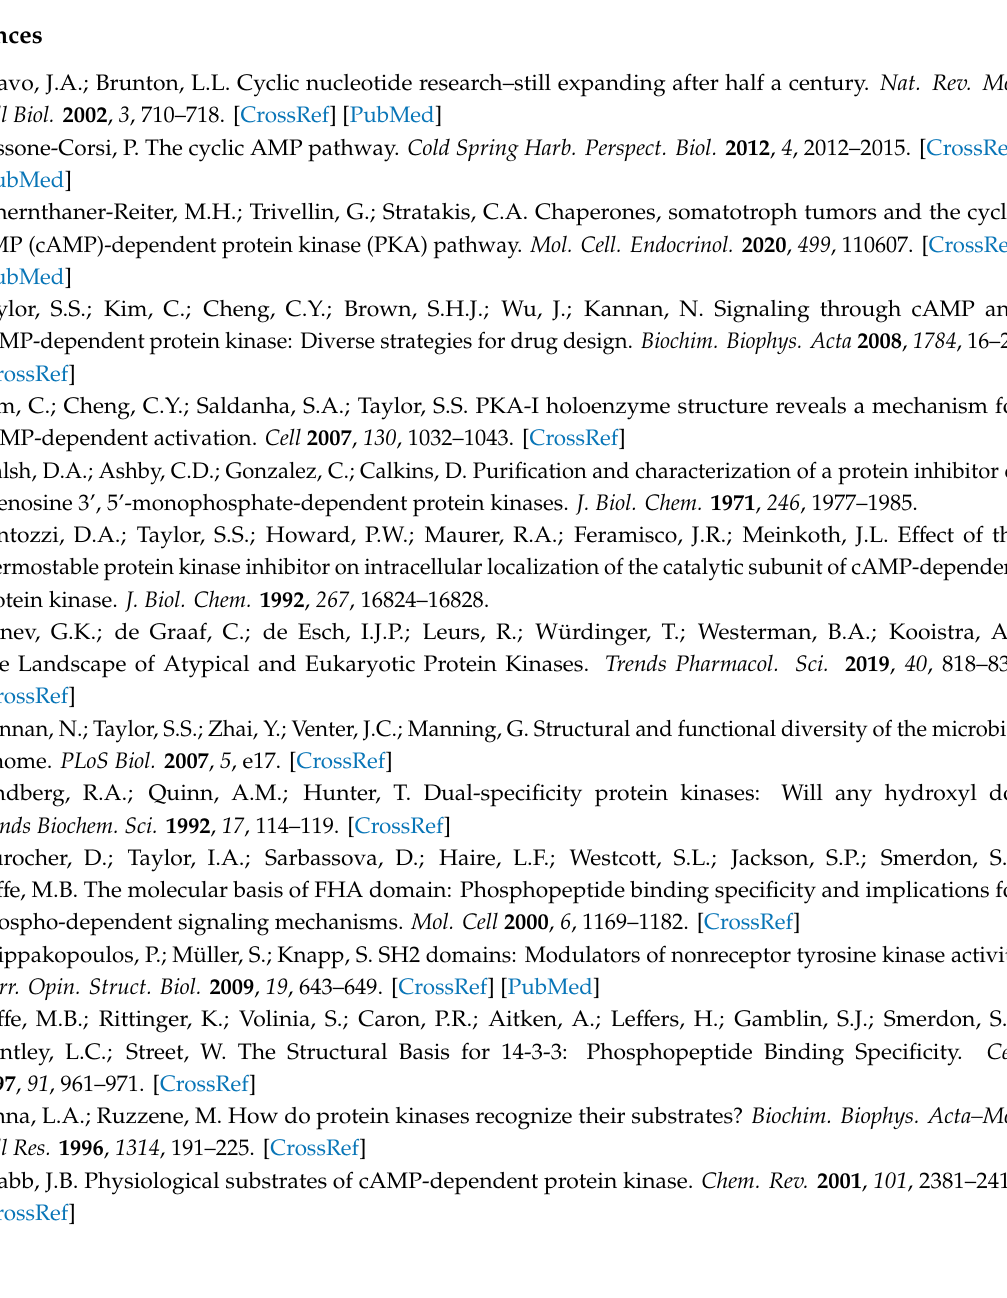
GST-PKI, Figure S9: Biochemical analyses of PKA C α F187V, Figure S10: Cushing’s syndrome mutant PKA C β 1 S53L has increased serine